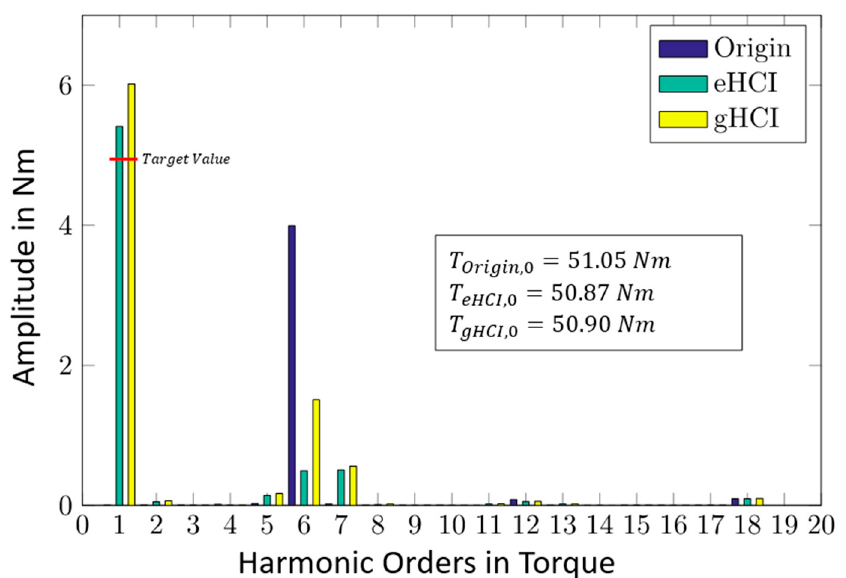
Figure 7. Order spectrum for scenario S1. For better readability, the bars for the zeroth order have been hidden and indicated by their numerical values. Extended harmonic current injection (eHCI) corresponds to the method from Section 3. Generative harmonic current injection (gHCI) corresponds to the approach from [24].